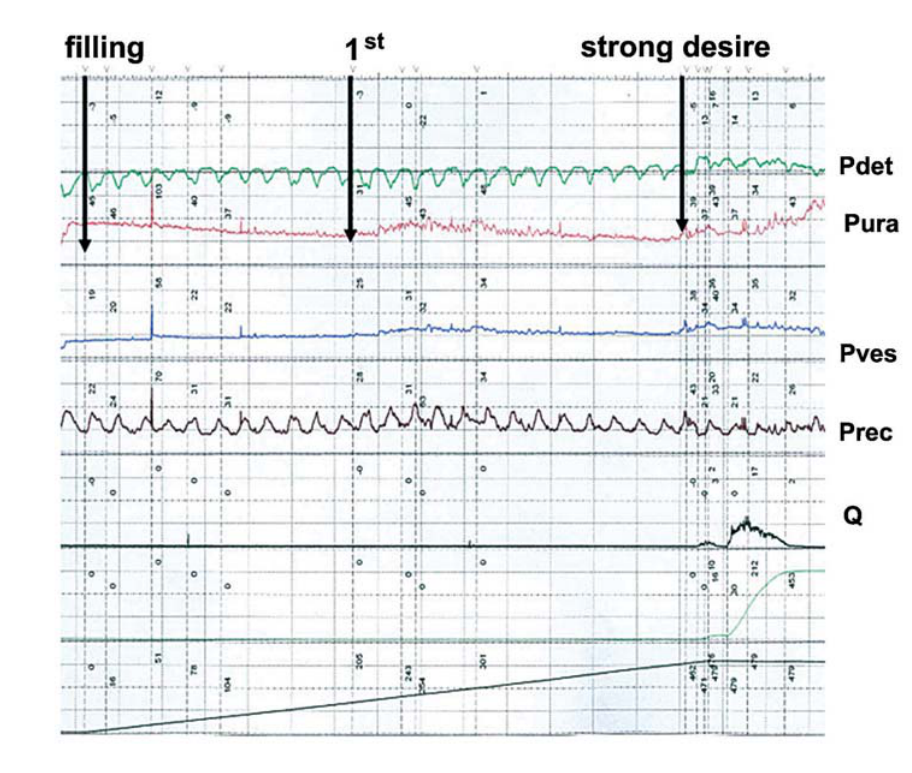
Figure 3 – (cid:3)(cid:40)(cid:91)(cid:68)(cid:80)(cid:83)(cid:79)(cid:72)(cid:3)(cid:82)(cid:73)(cid:3)(cid:68)(cid:3)(cid:83)(cid:68)(cid:87)(cid:76)(cid:72)(cid:81)(cid:87)(cid:3)(cid:90)(cid:75)(cid:82)(cid:3)(cid:75)(cid:68)(cid:71)(cid:3)(cid:85)(cid:75)(cid:92)(cid:87)(cid:75)(cid:80)(cid:76)(cid:70)(cid:3)(cid:85)(cid:72)(cid:70)(cid:87)(cid:68)(cid:79)(cid:3)(cid:70)(cid:82)(cid:81)(cid:87)(cid:85)(cid:68)(cid:70)(cid:87)(cid:76)(cid:82)(cid:81)(cid:86)(cid:3)(cid:71)(cid:88)(cid:85)(cid:76)(cid:81)(cid:74)(cid:3)(cid:68)(cid:79)(cid:79)(cid:3)(cid:87)(cid:75)(cid:72)(cid:3)(cid:191)(cid:79)(cid:79)(cid:76)(cid:81)(cid:74)(cid:3)(cid:70)(cid:92)(cid:86)(cid:87)(cid:82)(cid:80)(cid:72)(cid:87)(cid:85)(cid:92)(cid:17)